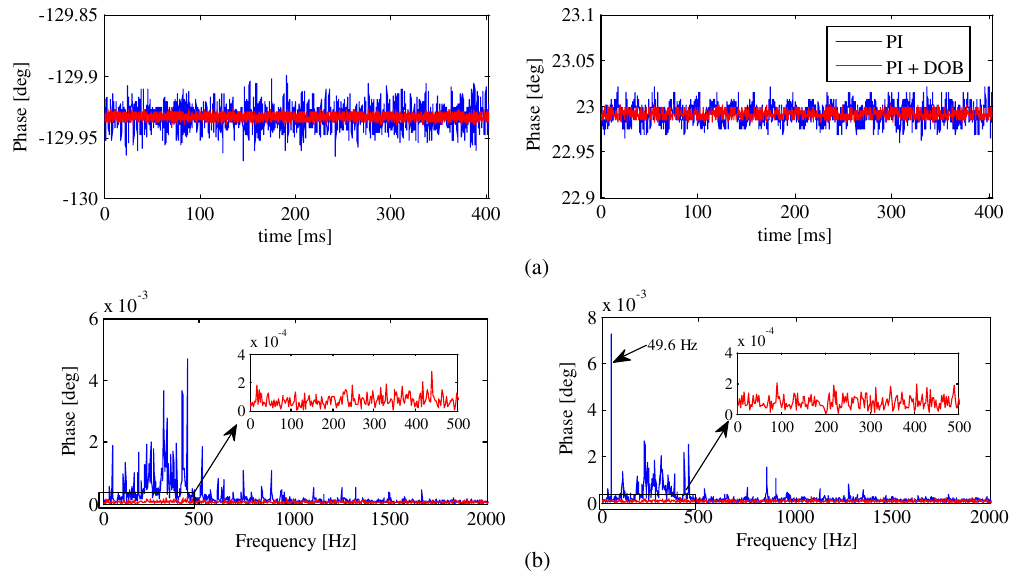
FIG. 19. Measured rf phase of the pickup signal in the main linac1 (left) and main linac2 (right) cavities in the case of PI individual control (blue) and PI þ DOB control (red) with 5 kHz Q filter. From top to bottom: (a) waveform,